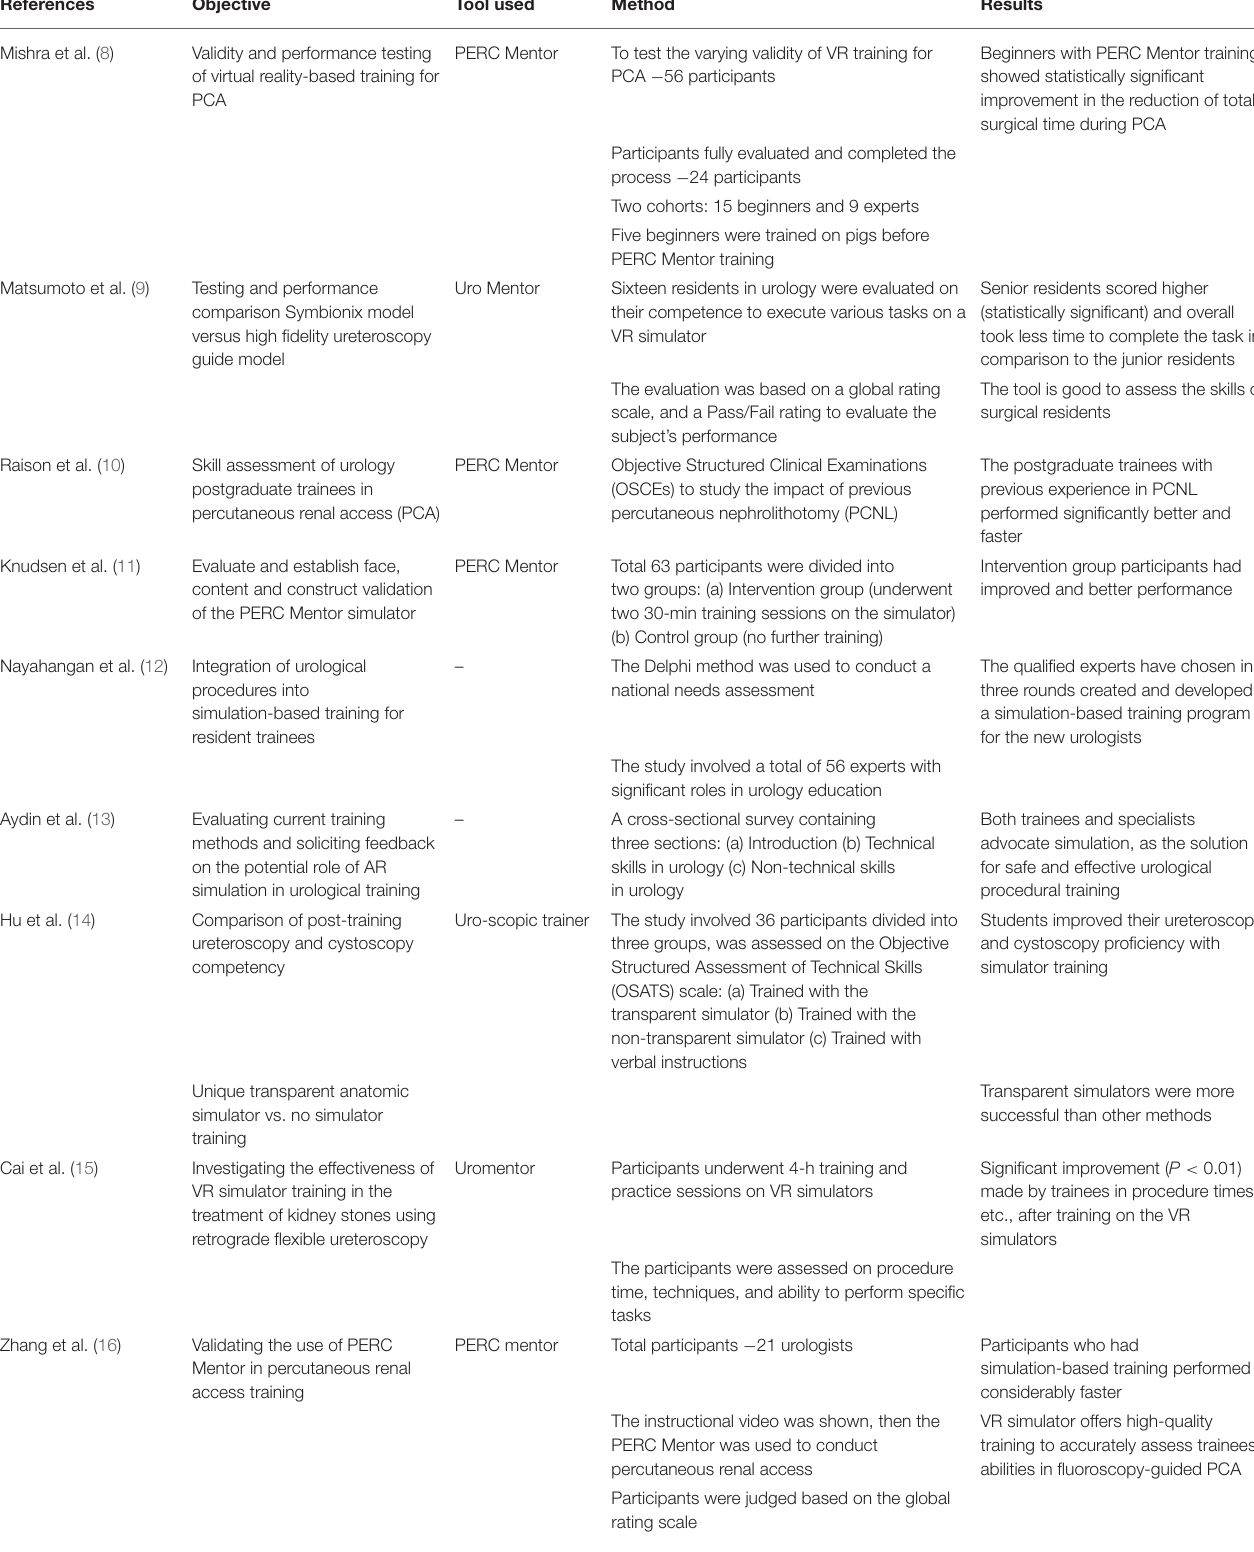
TABLE 1 | Summary of studies related to the application of virtual reality (VR), augmented reality (AR), and mixed reality (MR) in endourology and